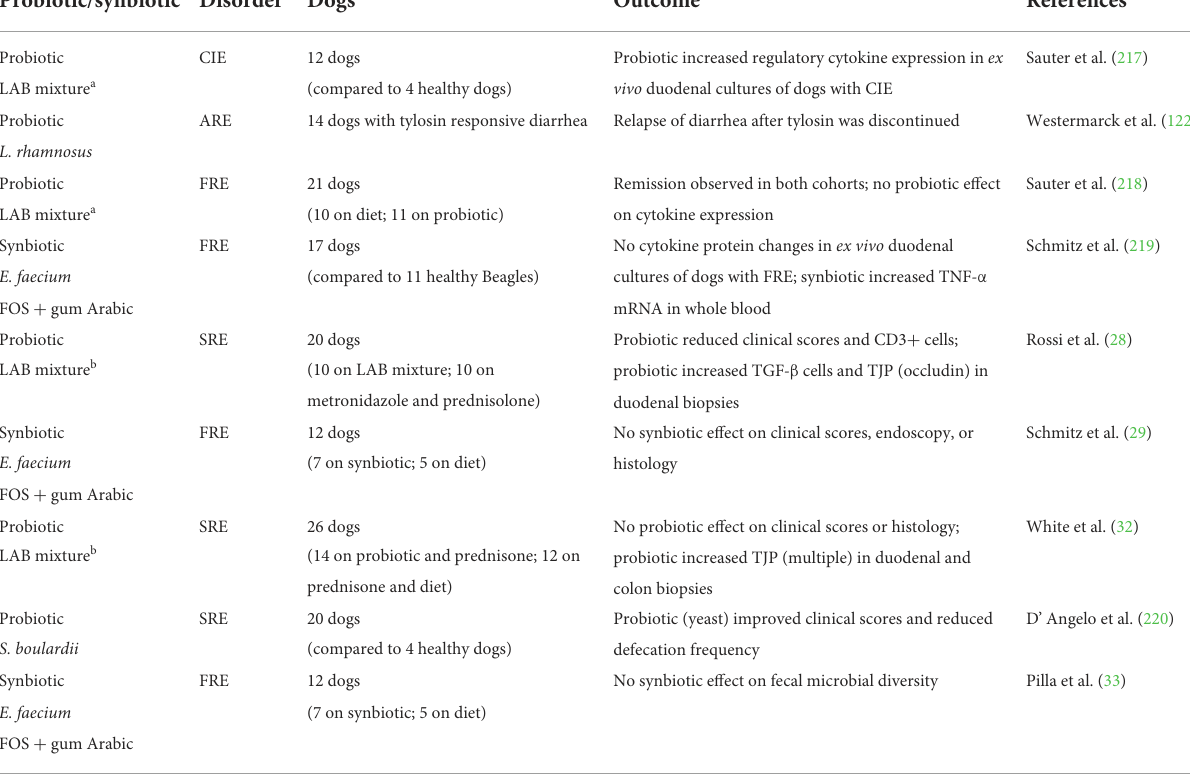
TABLE 4 Summary of published studies investigating probiotic or synbiotic use in dogs with CIE. Probiotic/synbiotic Disorder